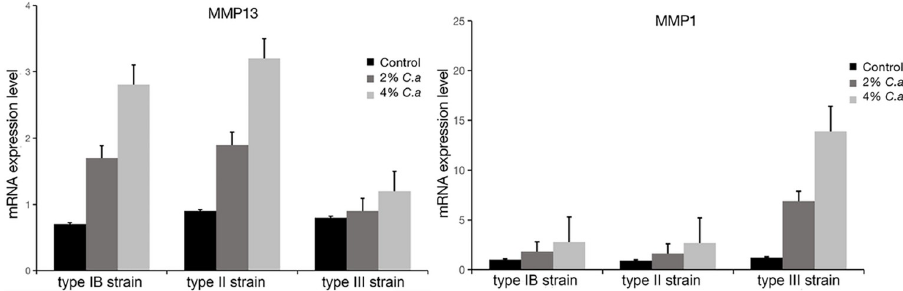
Fig 3. RT-qPCR analysis of MMP13 and MMP1 mRNA expression in endplate chondrocytes cocultured with 2% or 4% supernatant of different phylotypes of C . acnes . � p < 0.05, �� p < 0.01.